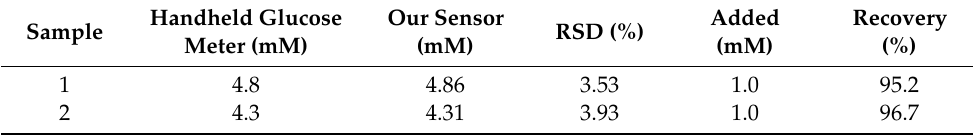
Table 3. Results for determination of glucose in human blood serum ( n = 3).